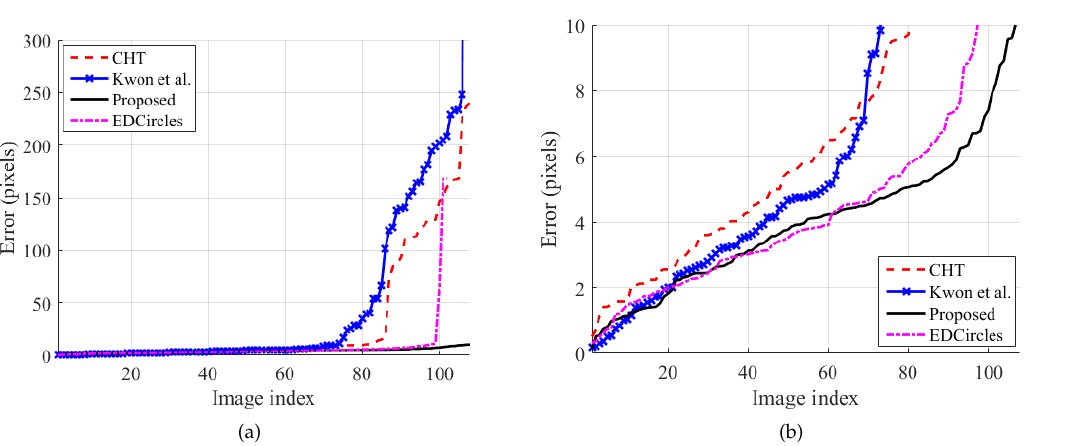
Figure 6. Circle detection accuracy (styrofoam ball set). The error is the distance from the best circle center detected by a method to its manually-recorded ground-truth center. For each method, the error has been sorted in ascending order, so the image indices do not match across the methods. ( b ) has been scaled from ( a ) to show the number of detected circles with low errors. Best viewed in color. CHT, Circular Hough